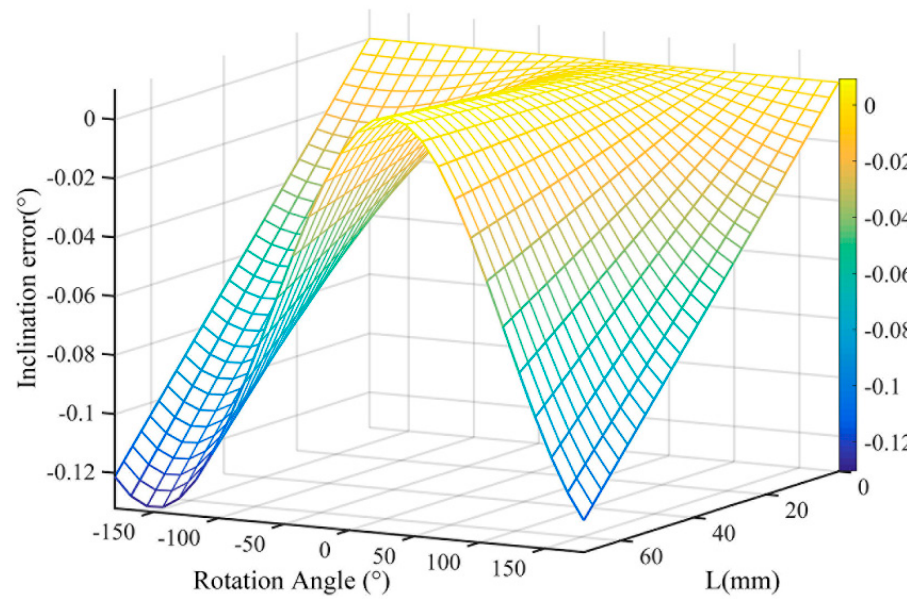
Figure 5. The inclination error varied with L (when θ = 0.1°). From the comparison of the data in Tables 2 and 3, it can be seen that the inclination error and the eccentricity error were in the same order of magnitude. The same conclusion can be drawn by comparing Figures 4 and 5. Therefore, when analyzing the angle mea- surement error of the circular grating, the inclination angle error is also a very important factor and cannot be ignored all the time.